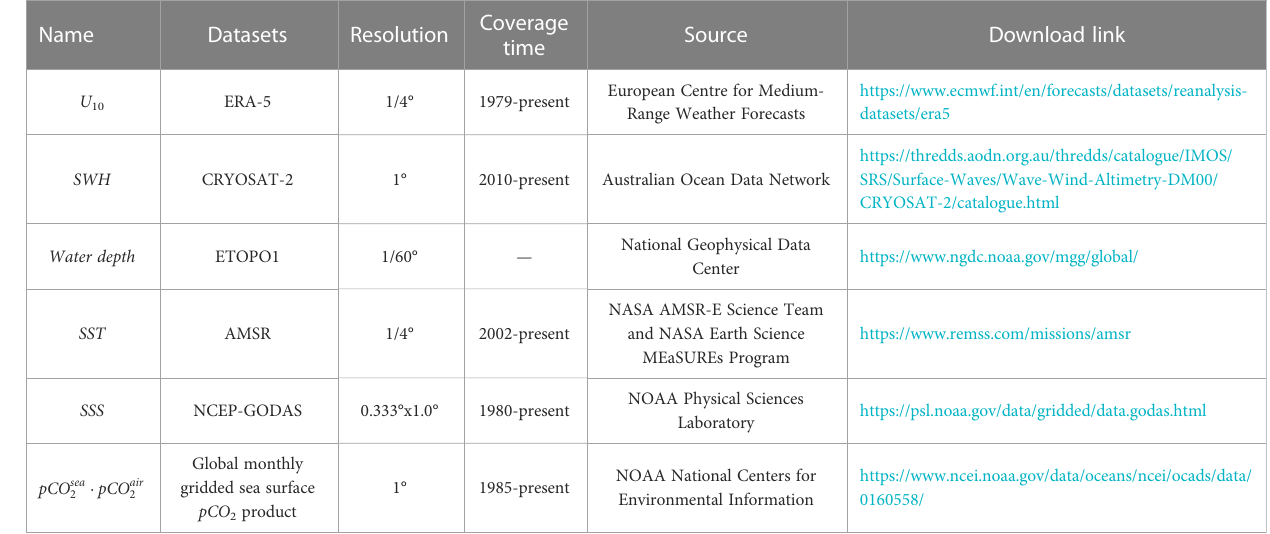
TABLE 1 Descriptions of data used in this study and their